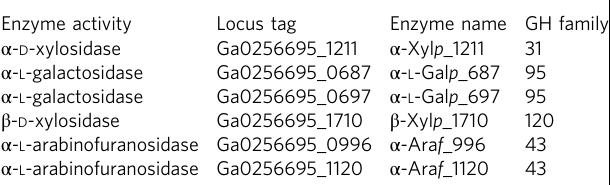
Table 3 Selected enzymes from LL1355. Enzyme activity Locus